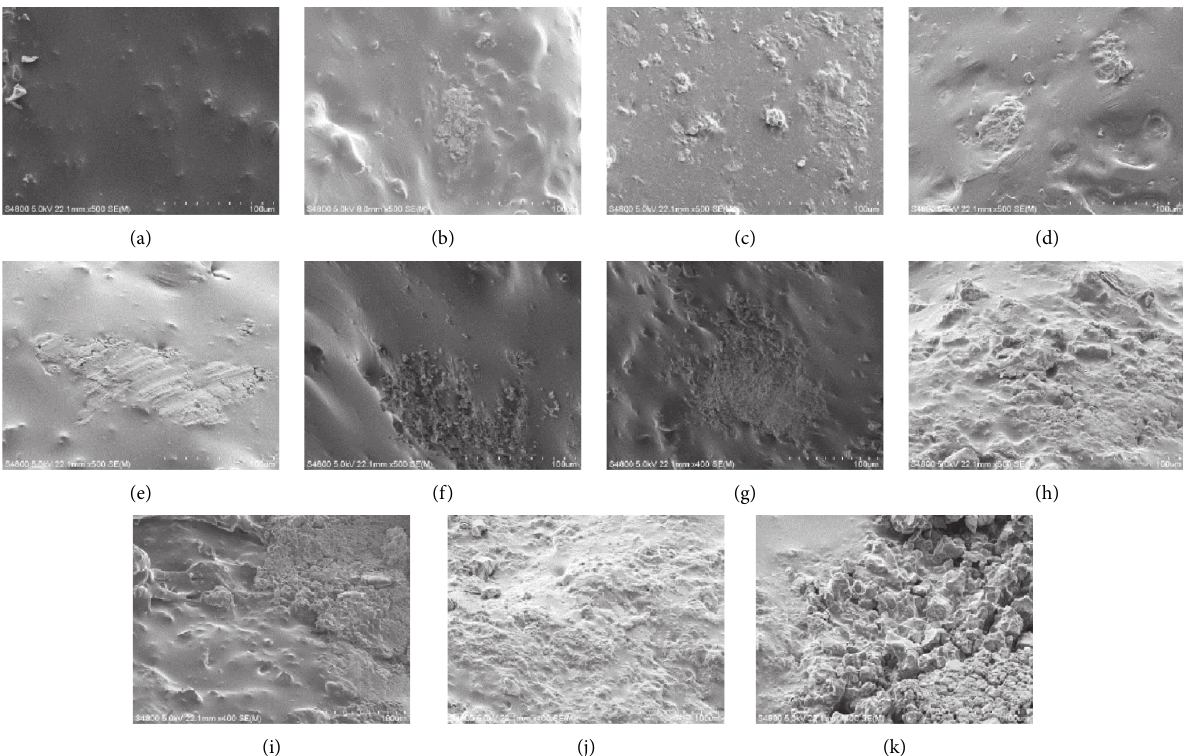
Figure 8: SEM images of PAC with a porosity of 24% after multiple freeze-thaw cycles. (a) No freezing-thawing. (b) 2 cycles. (c) 4 cycles.